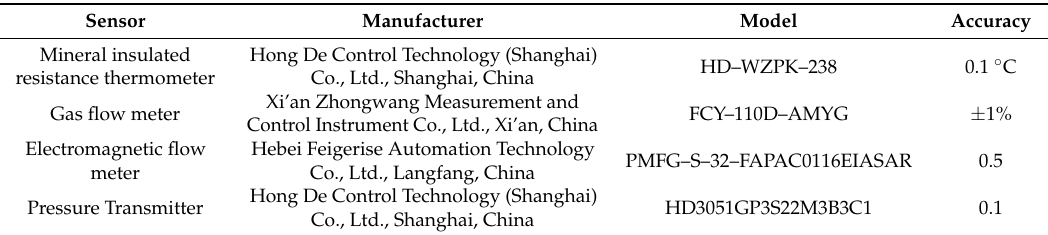
Table 2. Sensors used in the experiments.